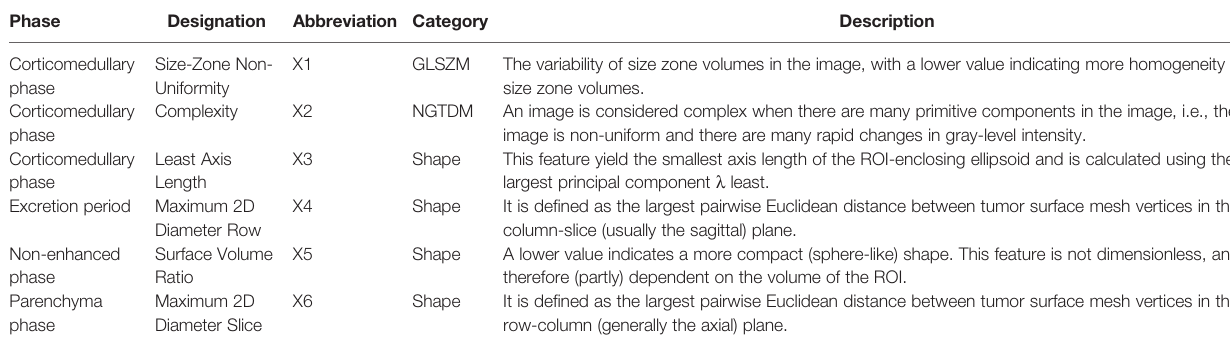
TABLE 2 | Patient ’ s selected RF ’ s designation, phase, abbreviation, classi fi cation, and